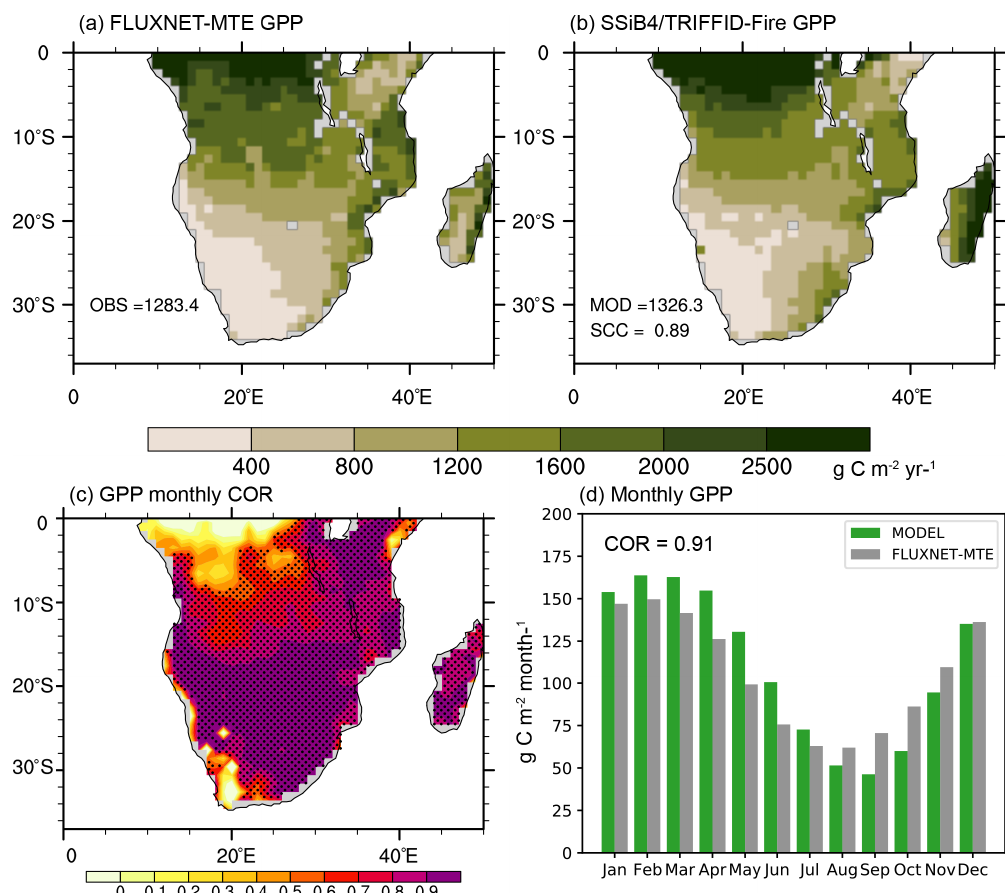
Figure 5. Annual GPP (gCm − 2 yr − 1 ) averaged over 2000–2011 in (a) FLUXNET-MTE and (b) SSiB4/TRIFFID-Fire; (c) point-by- point climatology monthly correlation between FLUXNET-MTE and SSiB4/TRIFFID-Fire (dots indicate the correlation is significant with p value<0.05); (d) monthly GPP (gCm − 2 month − 1 ) in model and